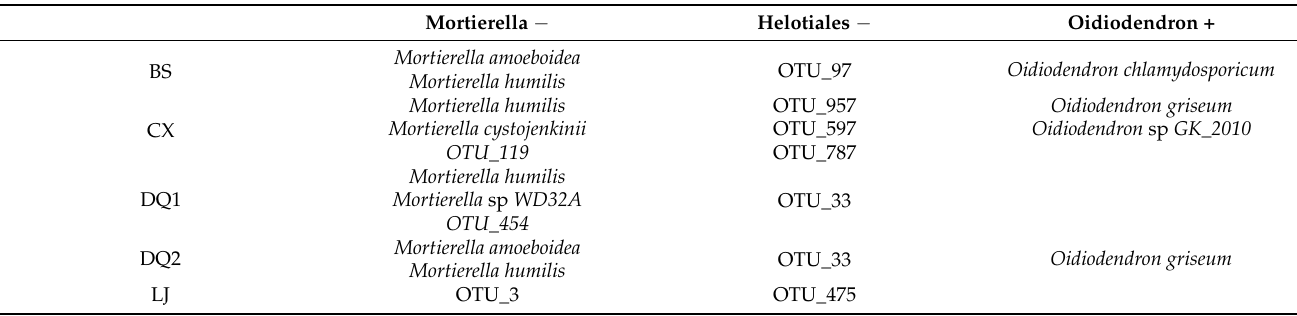
Table 2. The correlation between T.matsutake and other fungi groups. The + indicates positive correlation, whereas − indicates negative